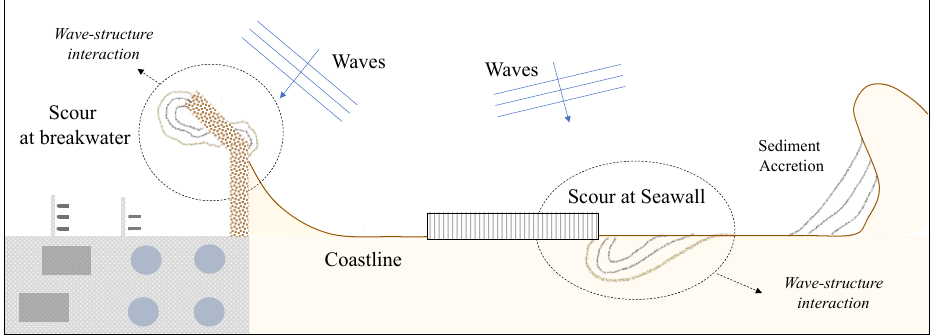
Figure 1. The schematic top view of the scour effect around maritime structures.